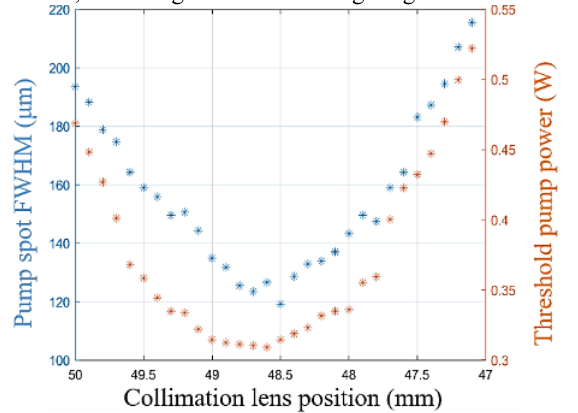
Fig. 3. Evolution of pump spot FWHM and threshold pump power with respect to collimation lens position away from the fibre’s end facet (L 1 in Fig. 1).